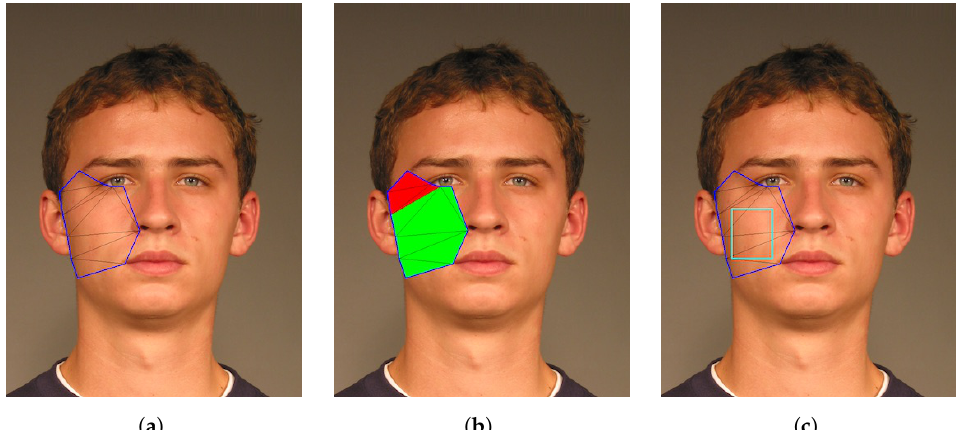
Figure 5. Illustration shows an example of how a tattoo placement in a region can be found. The red area in ( b ) illustrates that there might be some areas within a selected region where a tattoo cannot be placed, e.g., if the area is reserved for another tattoo. ( a ) Selected region. ( b ) Find a subset of the region not occupied (the green area). ( c ) Find a placement for the